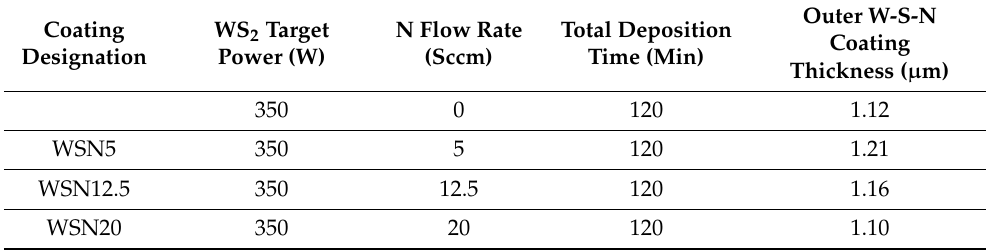
Main deposition parameters used during the synthesis of the coatings and the achieved